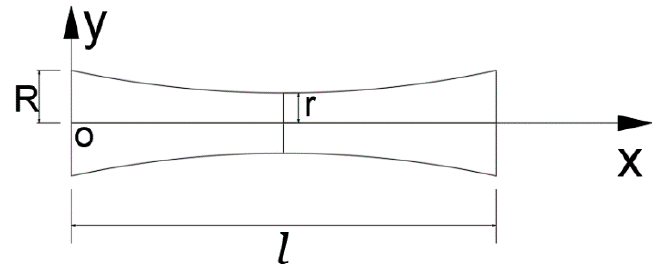
Figure 1. Variable cross-section core schematic illustration.